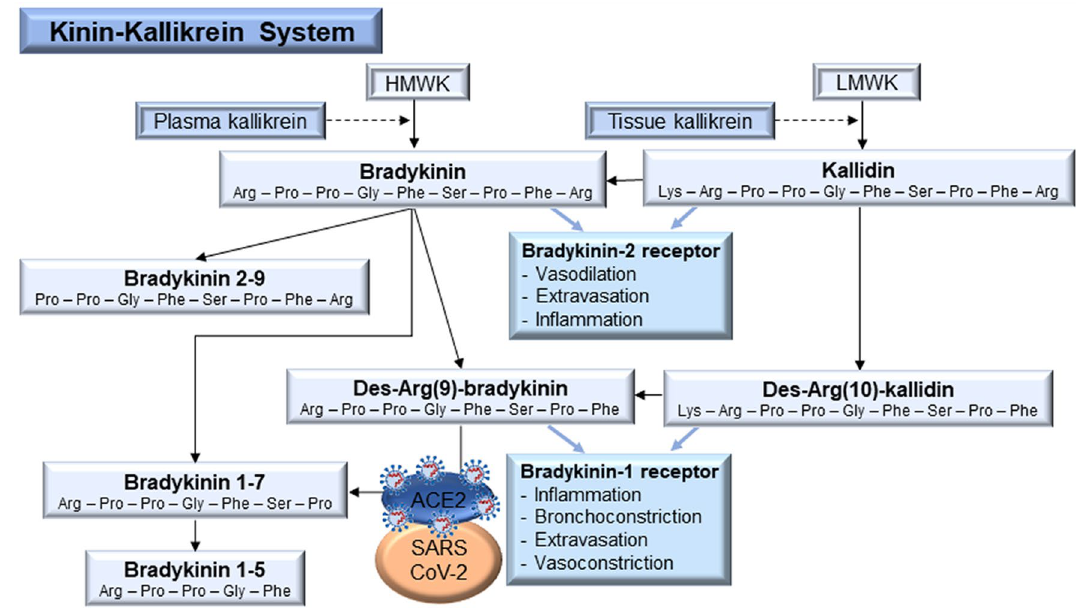
Figure 1. The kinin-kallikrein system and postulated connection with coronavirus disease 2019. ACE 2: angiotensin-converting enzyme 2, HMWK: high molecular weight kininogen, LMWK: low molecular weight kininogen, SARS-CoV-2: severe acute respiratory syndrome coronavirus